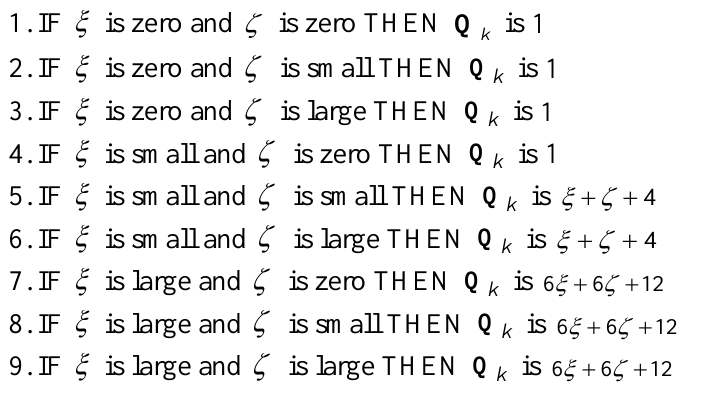
Figure 9. Membership functions of input fuzzy variables  (top) and 